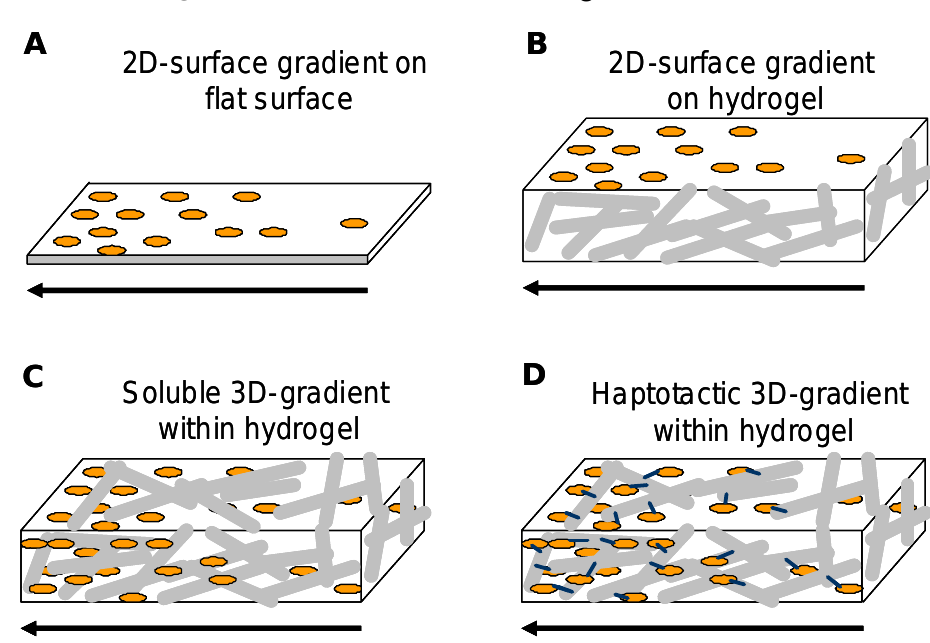
Figure 1. Schematic of 2D and 3D-gradient